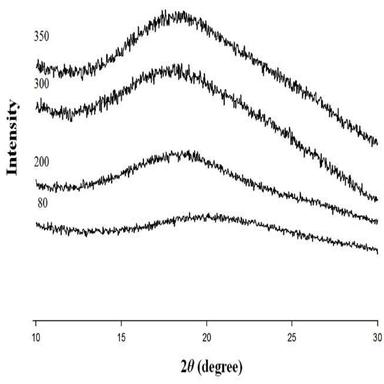
XRD patterns of PI films at different temperatures (° C).